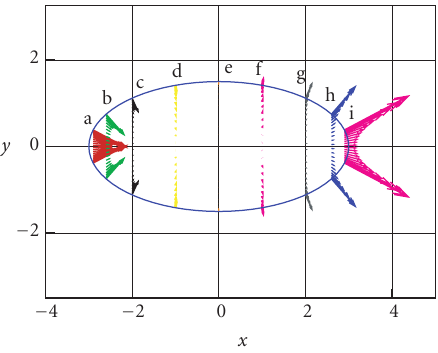
Figure 6.1. Distribution of the normal stress at the surface of a tri-axial ellipsoid, immersed in a uniform stream that moves from left to right. Two-dimensional representation in the ( x , y )-plane of an ellipsoid (with semiaxes a = 3, b = 1 . 5, c = 0 . 75 cm). The arrows represent the normal stress ( T nn n x + T nn n y ) / 150dyn/cm 2 evaluated for di ff erent cross sections along the ellipsoid. The cross sec- tions are located at (a) x = − 2 . 9, (b) − 2 . 6, (c) − 2 . 0, (d) − 1 . 0, (e) 0 . 0, (f) 1 . 0, (g) 2 . 0, (h) 2 . 6, and (i) 2 .